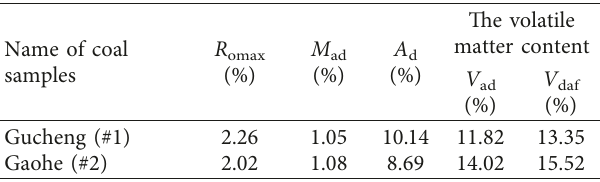
Table 1: Analysis results of experimental